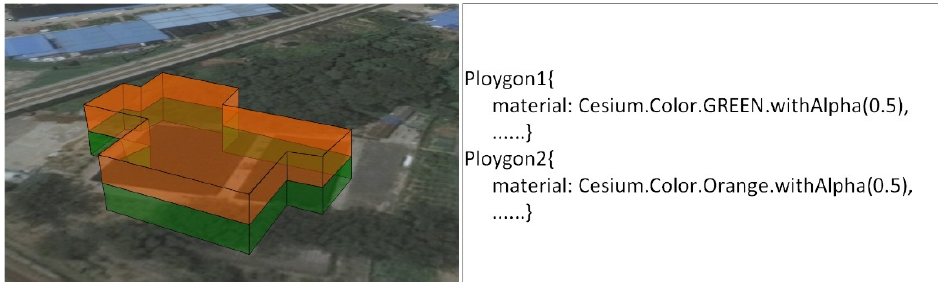
Figure 14. 3D visual color fill diagram and code.